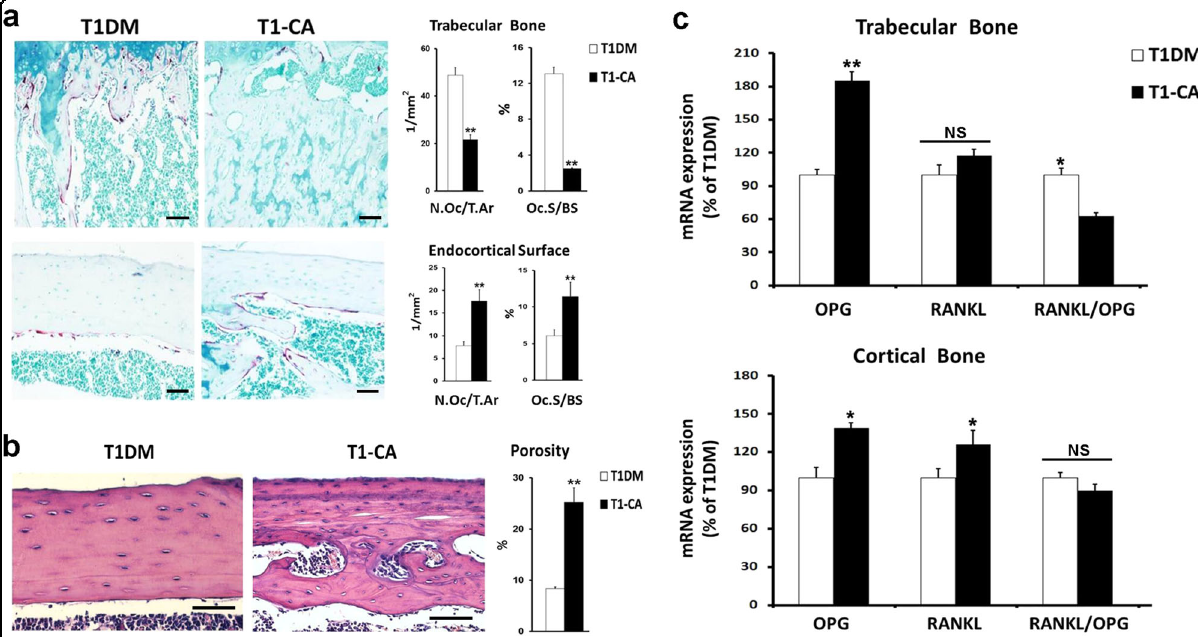
Fig. 4 Osteoblastic activation of β -catenin in T1DM mice increased osteoclasts activities and bone porosity in cortical bone but not in trabecular bone. a Representative images of TRAP staining and histomorphometric quanti fi cation of TRAP-stained osteoclasts in femoral trabecular and cortical bone. n = 9. Scale bars, 50 μ m. b Representative images of H&E-stained longitudinal sections of the femoral diaphysis. The cortical porosity was quanti fi ed by histomorphometry and represented graphically. n = 9. Scale bars, 40 μ m. c mRNA expression levels of osteoclast regulating factors in trabecular and cortical bone. n = 8. RANKL receptor activator of nuclear kappa B ligand, OPG osteoprotegerin. Data are expressed as the mean ± SD. * P < 0.05, ** P < 0.01 versus T1DM group by an unpaired t -test. N, not signi fi cant, P >